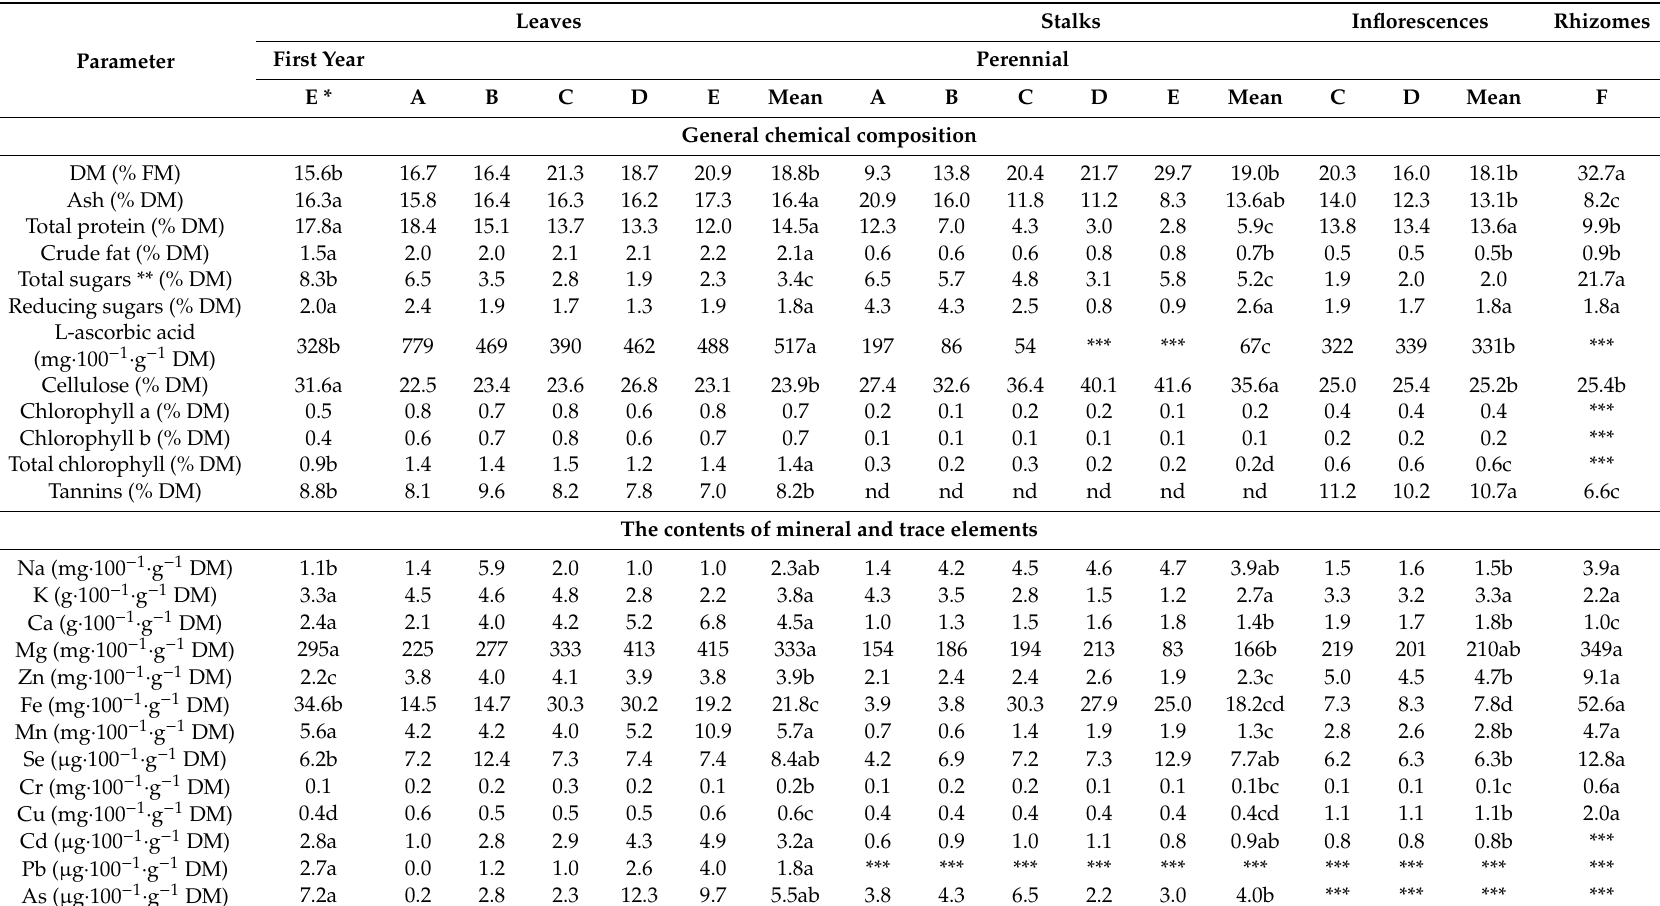
Table 5. Chemical composition of Silphium integrifolium